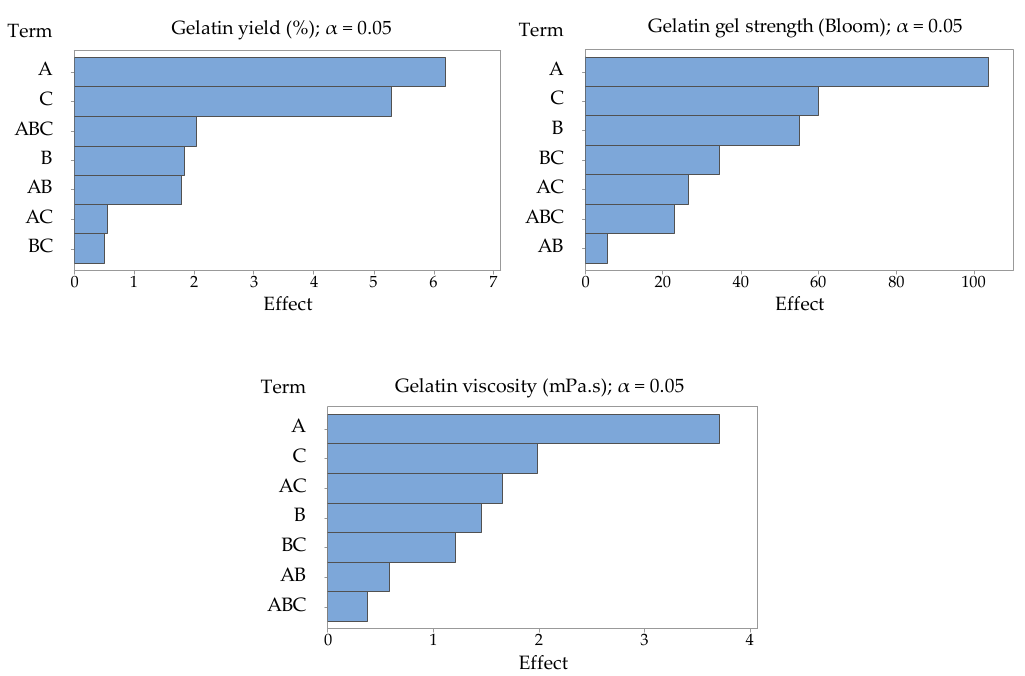
Figure 1. Pareto charts of the effects of studied process factors (A–amount of enzyme, B–enzyme conditioning time, and C–extraction time) and their interactions on gelatin yield, gelatin gel strength, and gelatin viscosity.